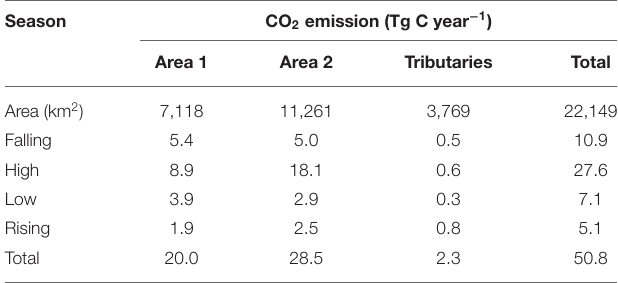
TABLE 3 | Seasonal CO 2 emissions in the Amazon River channel considering different